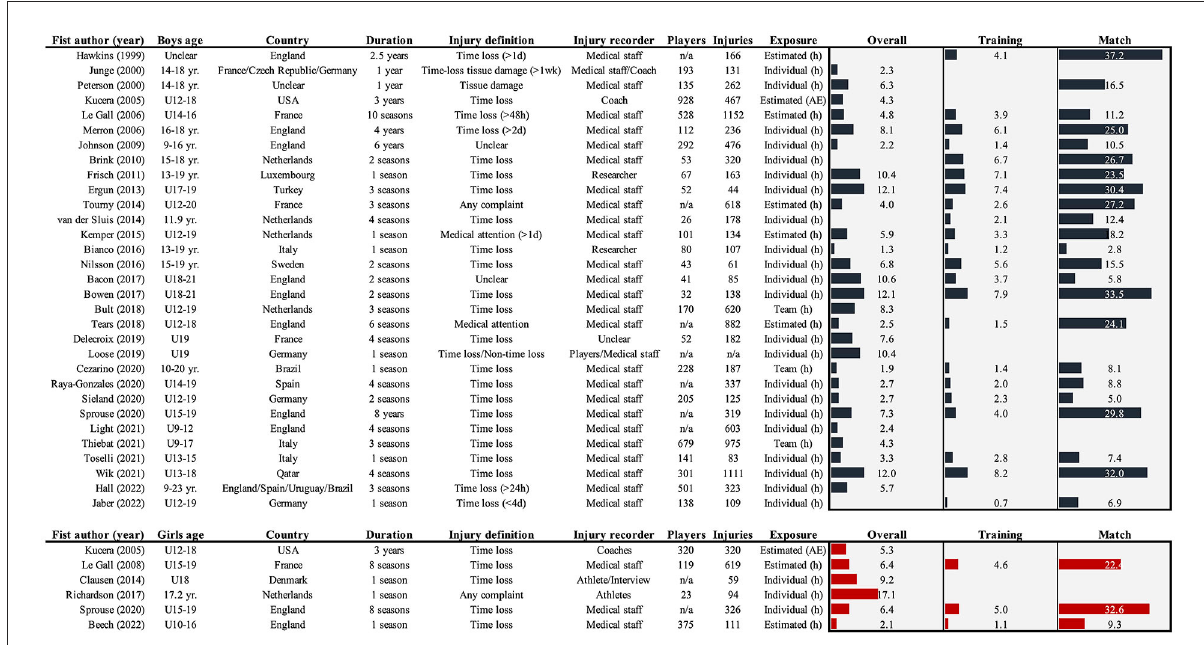
FIGURE1 Overview of studies reporting overall, training and/or match injury rates (per 1,000h or athletic exposures: AE) in high-level youth football players. Where estimates were only provided for subgroups, the average was used to give an idea of the extent, and where rates were presented using multiple definitions, only the narrowest was included (e.g., time loss > medical attention) as these are more comparable between contexts (45). If datasets were overlapping or used in multiple studies, only the main epidemiological study was included.